Question: Give a one-sentence summary of this figure.
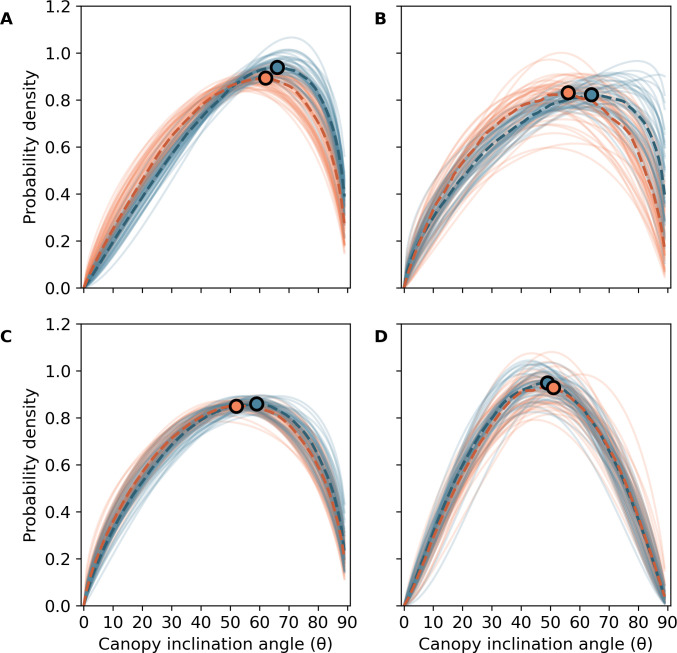
Answer: Fitted beta distributions of canopy inclination angles for all genotypes at the heading (A) and anthesis (C) stages in 2022 and at the booting (B) and anthesis (D) stages in 2023. Each solid-colored line represents one individual genotype. Blue lines represent erectophile phenotypes, while red lines indicate planophile phenotypes. Dotted lines show median values, and filled circles mark the maximum angles from the median values for each group.